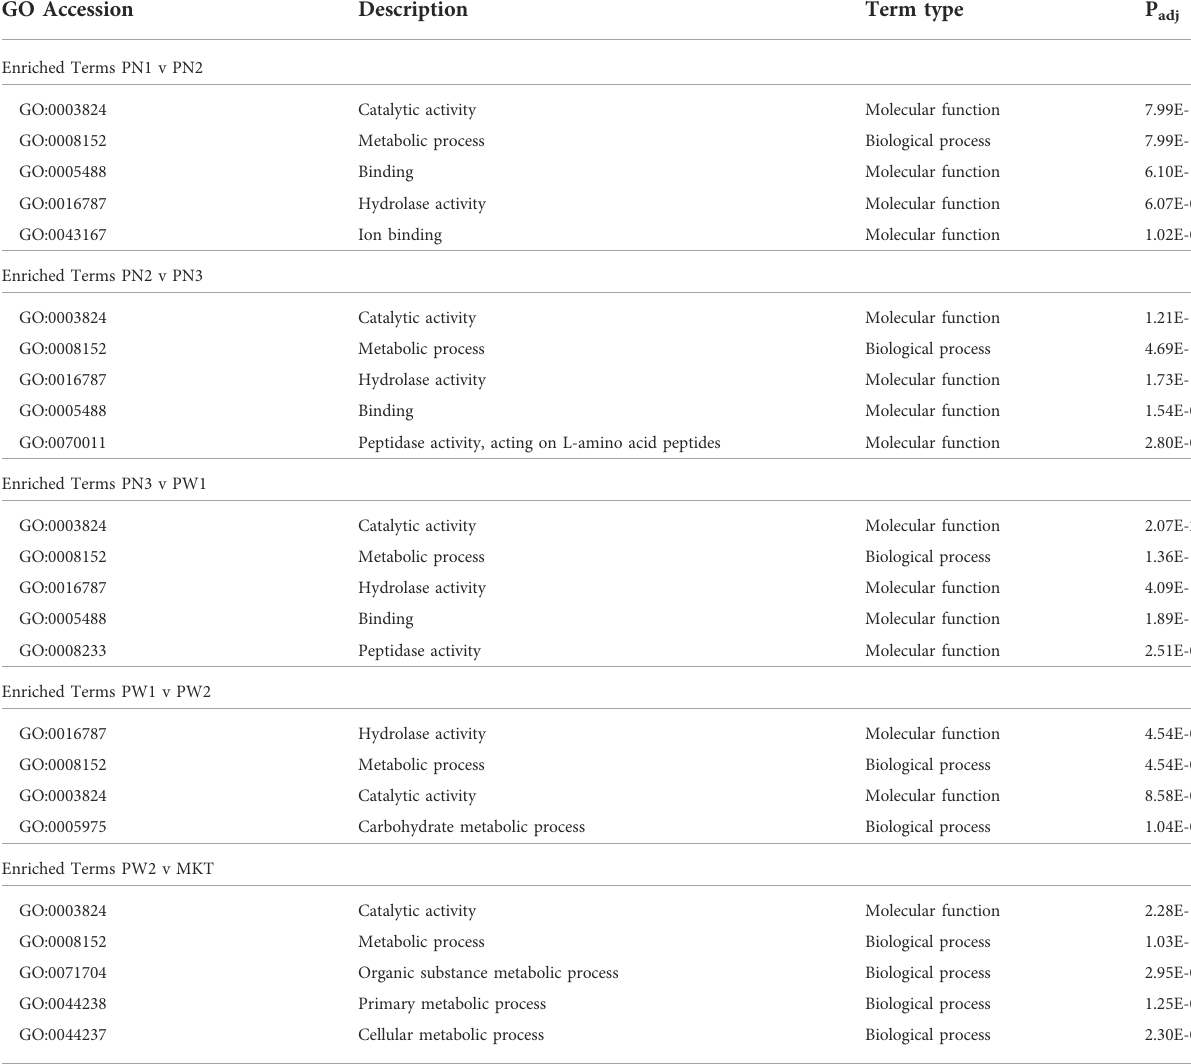
TABLE 6 Summary of enriched Gene Ontology terms from each